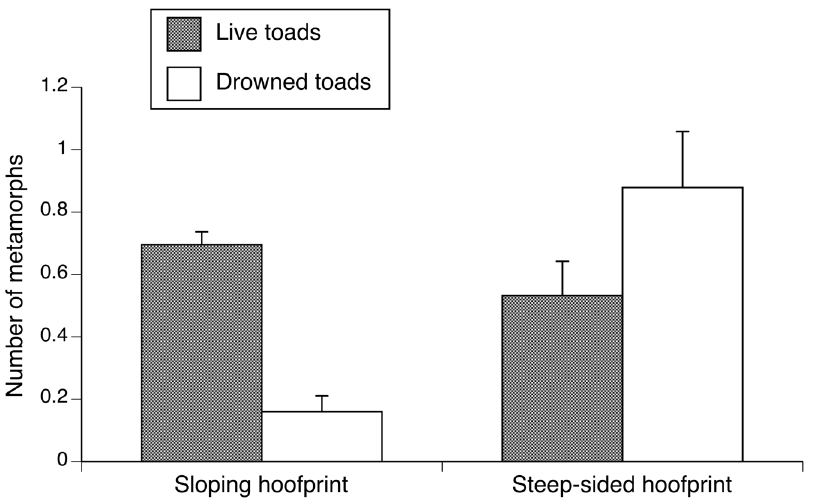
Figure 7. Number of toads found alive and dead (drowned) in hoofprints, during our field surveys performed immediately after a rain had finished.